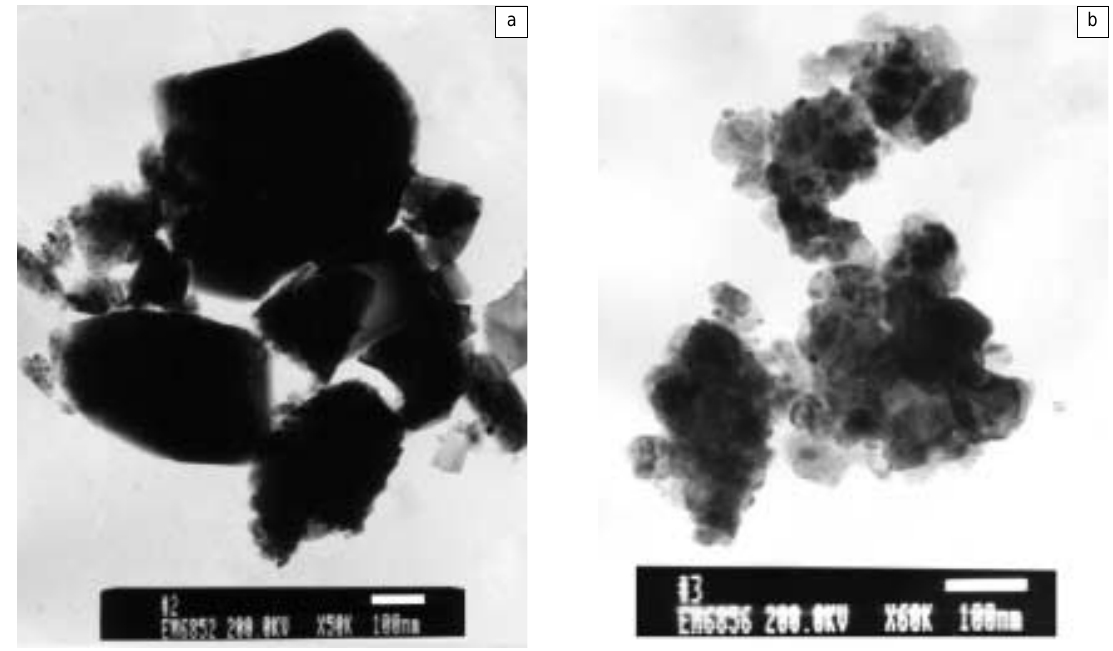
Fig. 18 Microphotograph of the SHS product of a BaO 2 (cid:4) WO 2 mixture (a), the same product after mechanical activation for 2 min.